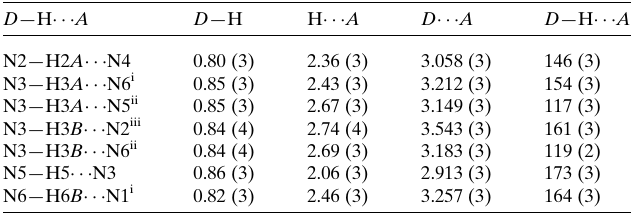
Table 1 Hydrogen-bond geometry (A˚ , (cid:3) ).